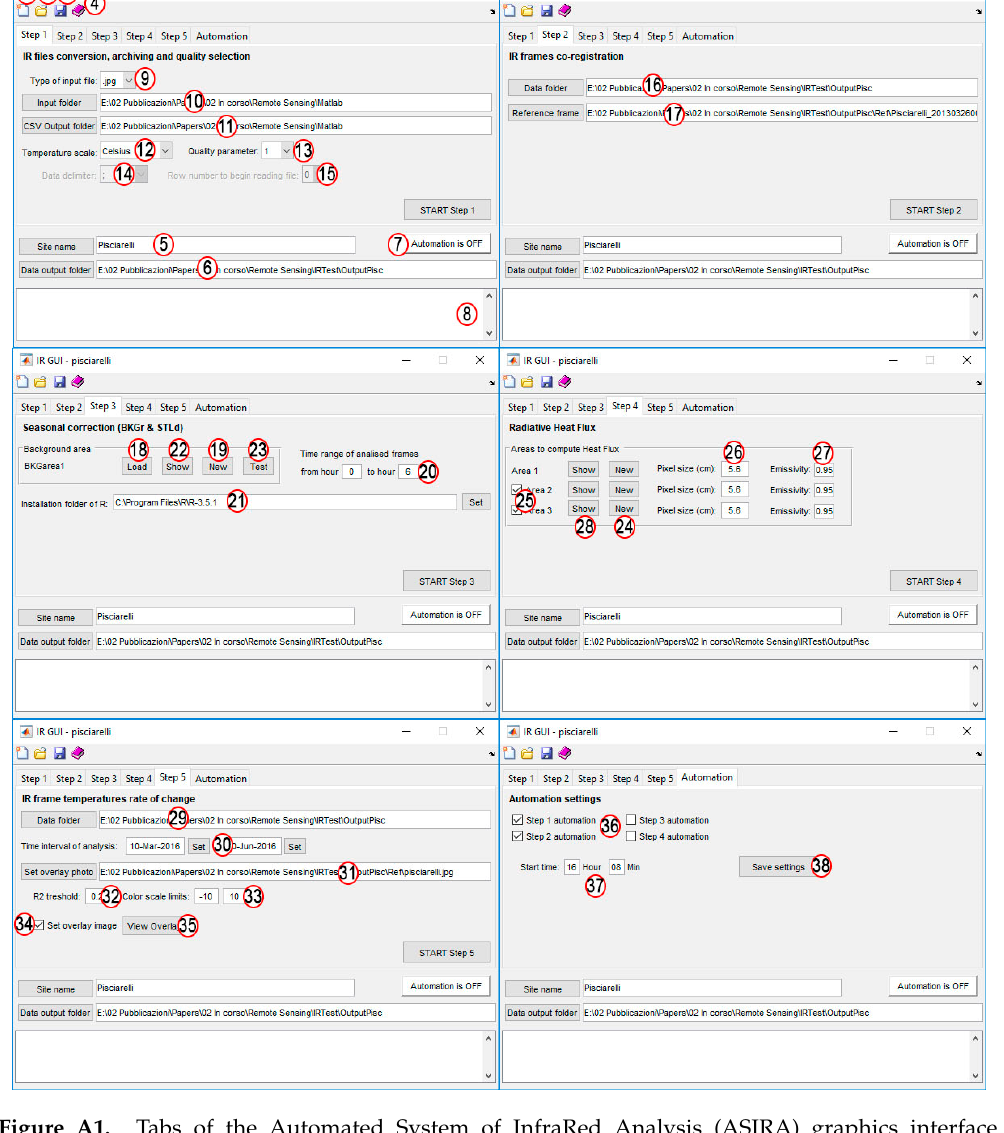
Figure A1. Tabs of the Automated System of InfraRed Analysis (ASIRA) graphics interface representative of five processing steps and automation settings. Numbers inside the red circles are the IDs reported in the technical sheets of Appendix A.